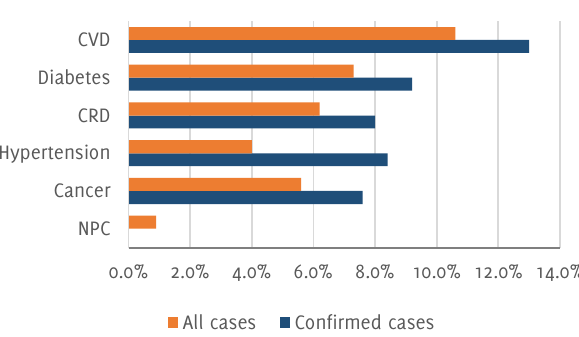
Figure 4. COVID-19 Fatality Rate by Comorbidity.